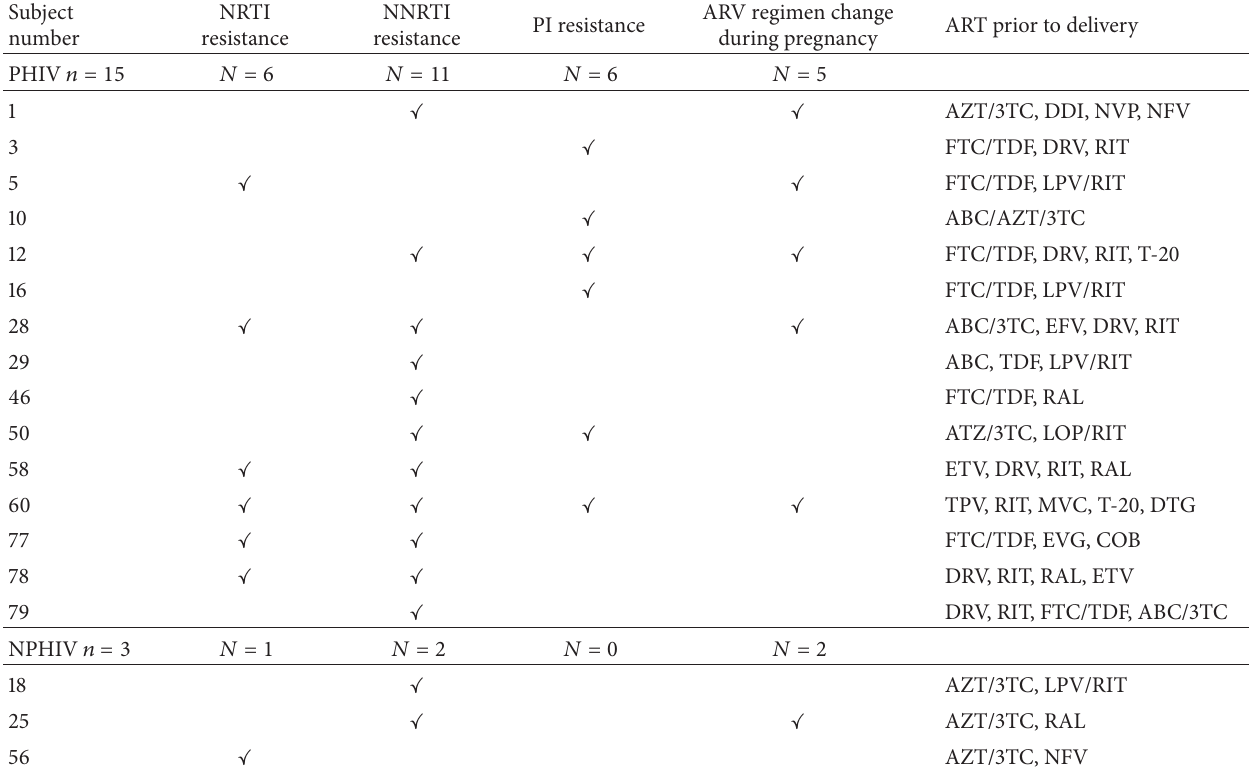
Table 3: Antiretroviral drug resistance patterns in HIV-infected pregnant